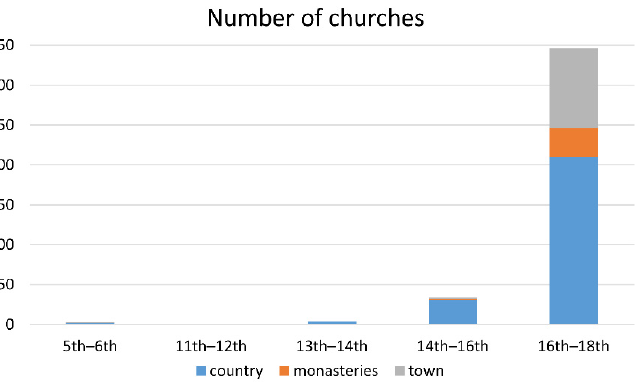
Figure 3. The number of monasteries and churches built in towns and in the countryside on the island of Paros from the 5th to the 18th century (data and graph by the